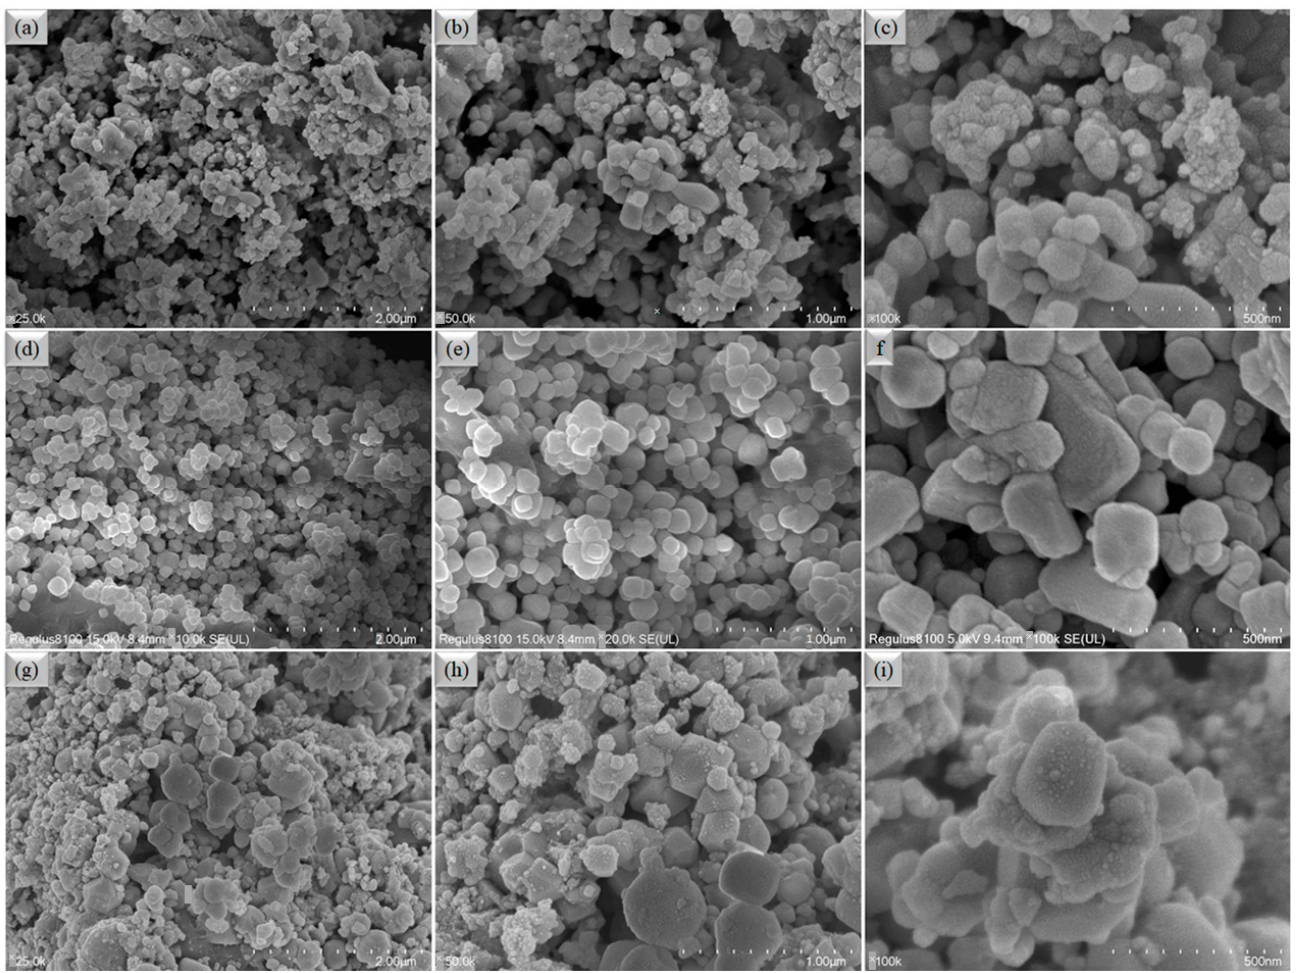
Figure 2. ( a – c ) SEM image of LSCF; ( d – f ) SEM image of the prepared GDC; and ( g – i ) SEM image of the LSCF-GDC heterostructure composite image, respectively.